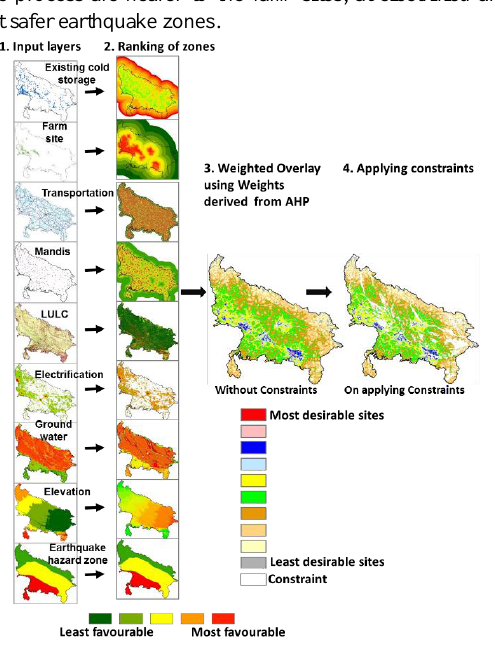
Figure 3. Analysis of factors for site selection of cold storages